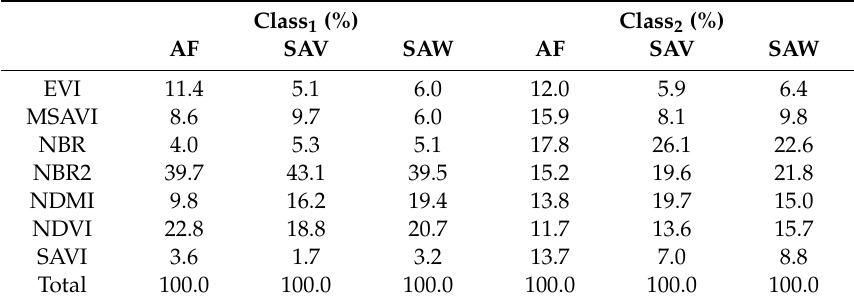
Table 1. Summary of proportions each spectral index disturbance map contributes to the classes class 1 and class 2 . Vegetation domains are represented by the following acronyms: Atlantic forest—AF, savanna—SAV, and semi-arid woodland—SAW. Class 1 (%) Class 2 (%) AF SAV SAW AF SAV